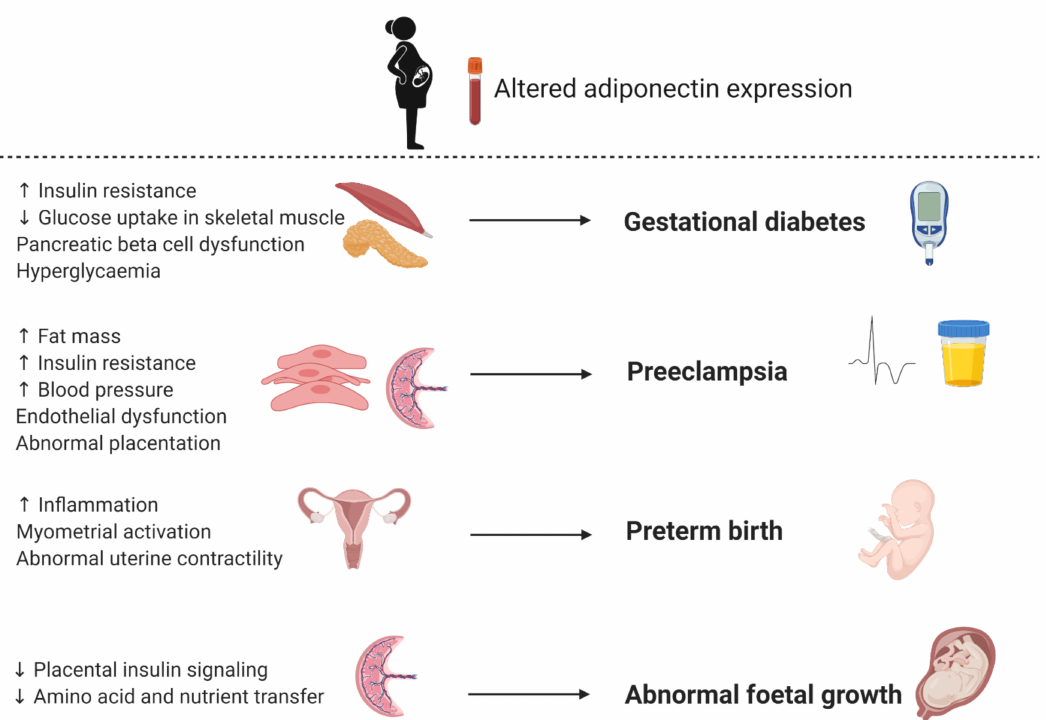
Figure 5. Schematic illustration of potential mechanisms linking altered adiponectin expression to pregnancy complications. Illustration created with